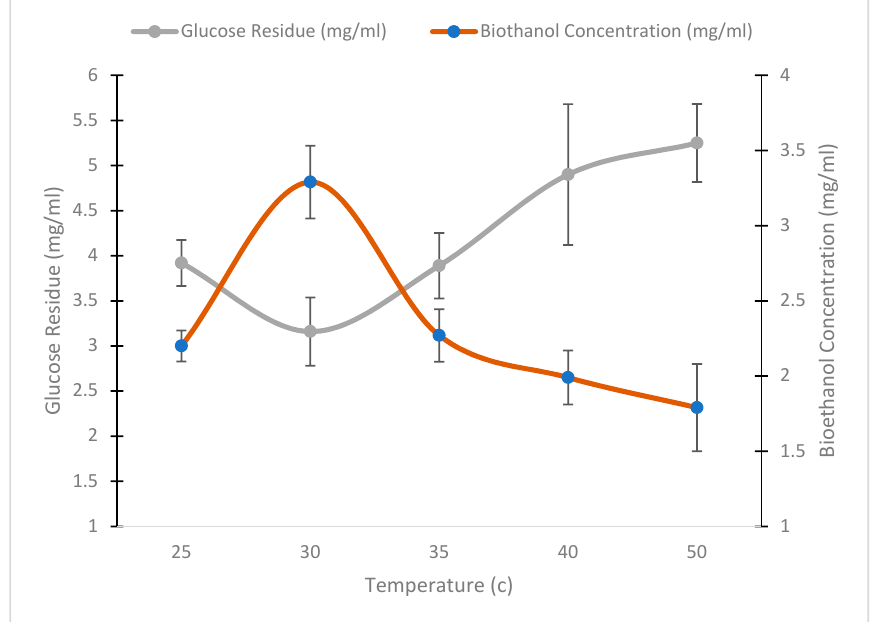
Figure 9. Effect of different incubation temperatures on the production of bioethanol with G4 yeast isolate and the determination of the residual glucose concentrations.